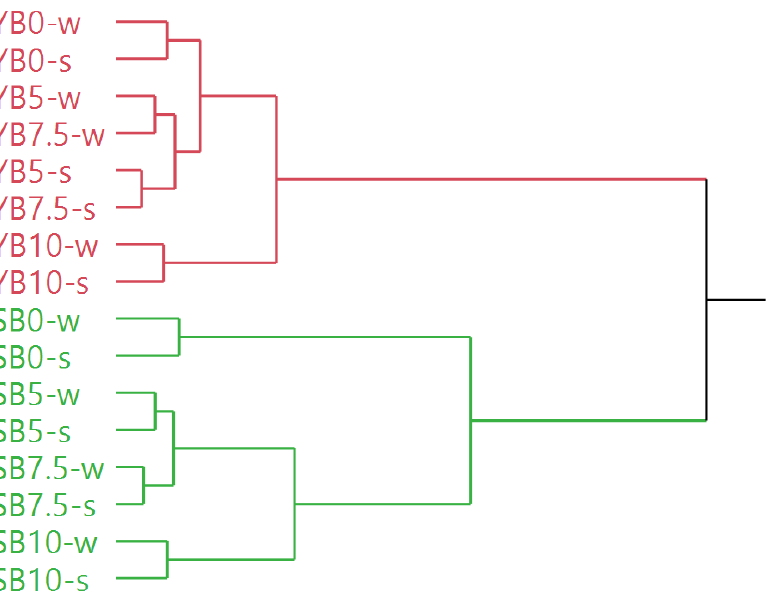
Figure 3. Hierarchical cluster analysis based on volatile compounds of breads (w = whole or s = sliced) as both a function of percentage of flaxseed flour and leavening agent used for fortification.